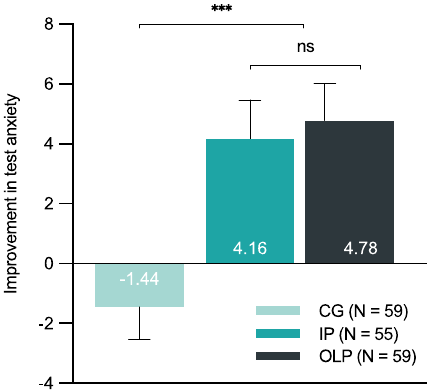
Figure 2. Mean improvement in test anxiety (PAF: test anxiety questionnaire) from baseline (T1) to endpoint (T4) per group. Results indicate a significant improvement for the OLP and IP group compared to the CG.